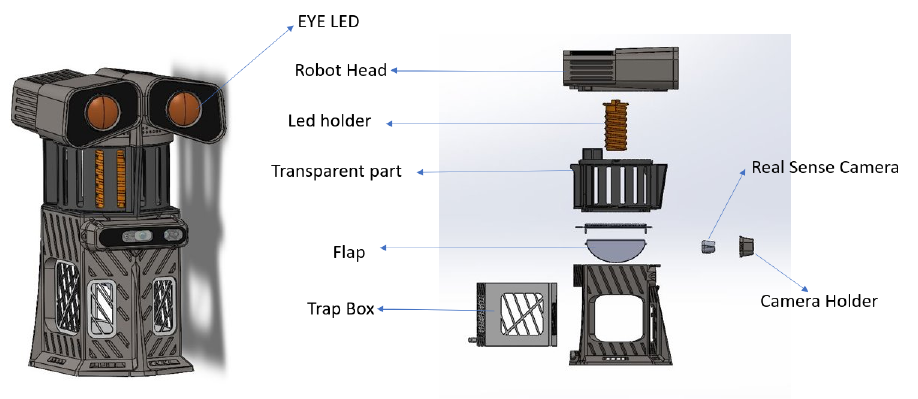
Figure 4. Mosquito trap